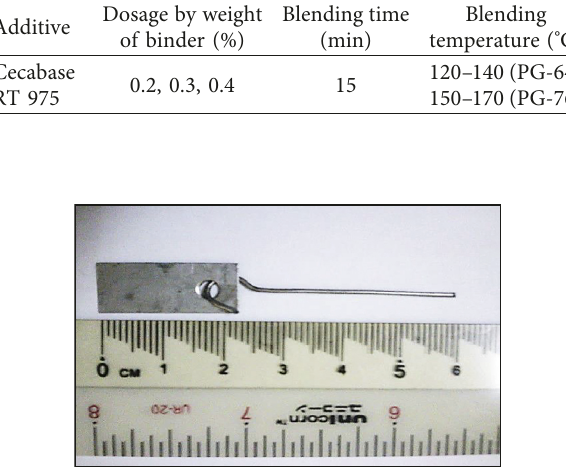
Figure 2: Metallic strip and hook designed for the DCA test